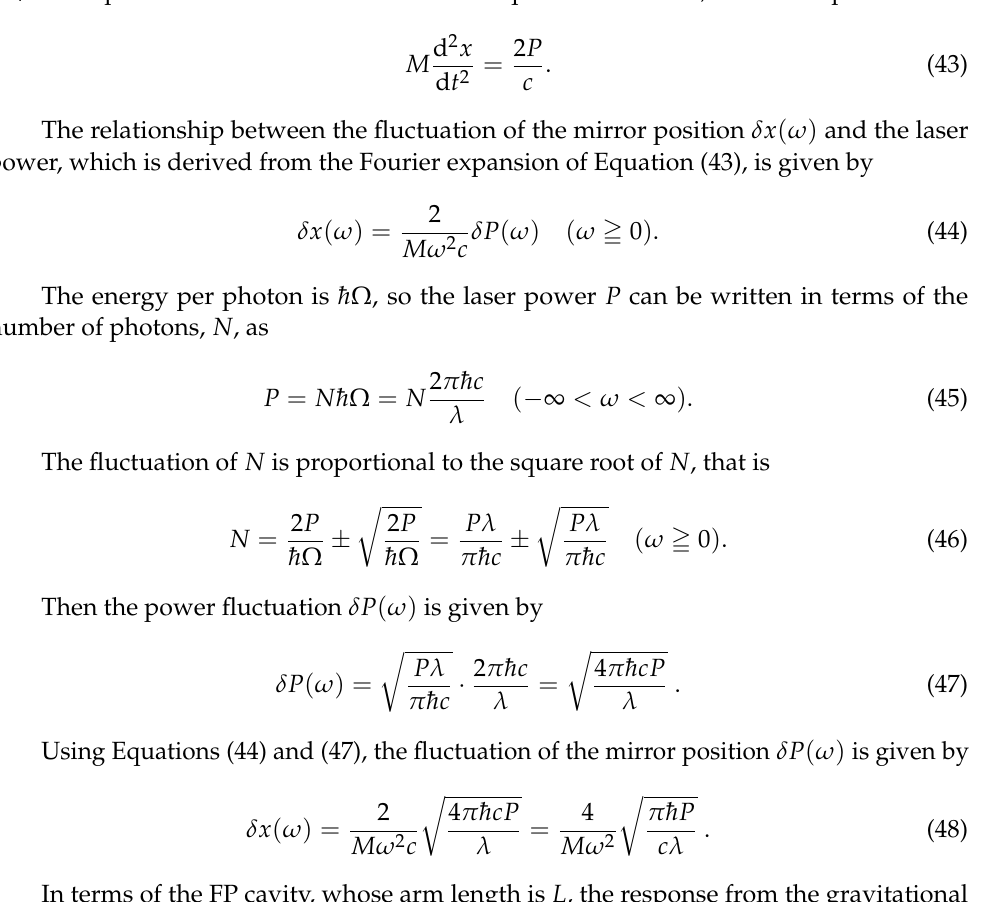
Figure 4. Differential FP interferometer used in the pre-conceptual design of DECIGO. The laser beam is divided into two beams by the beam splitter. Each arm has each photodetector and FP cavity. The radiation pressure noise of a FP cavity is derived from fluctuations of the mirror positions due to fluctuations of the laser power. The fluctuations of the laser power can be attributed to statistical fluctuations of the number of photons. The mirror is subject to the force from the laser radiation pressure. When the laser power is P , its force is represented as 2 P / c . The position x of the mirror follows the equation of motion, which is represented